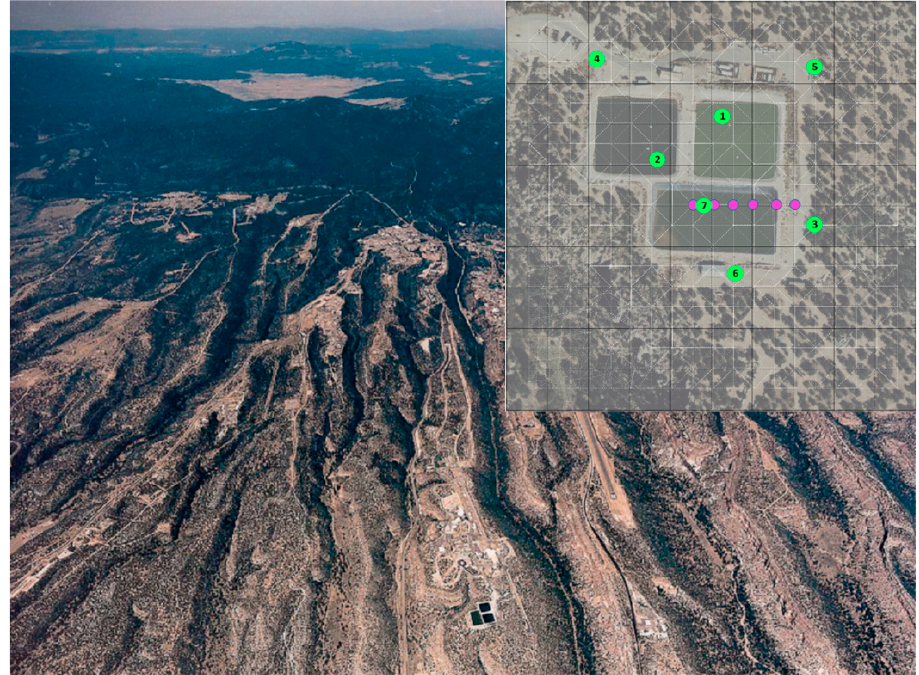
Figure 1. Aerial photograph of Los Alamos and the Pajarito Plateau looking west into the Jemez Mountains. The surface impoundments of TA ‐ 53, prior to remediation, are visible in the bottom middle of the figure (after Newman and Robinson, 2005). The inset shows the locations of the seven monitoring boreholes drilled in 2002 (green numbered circles) and the approximate trajectory of the unlined drainage ditch (pink circles).